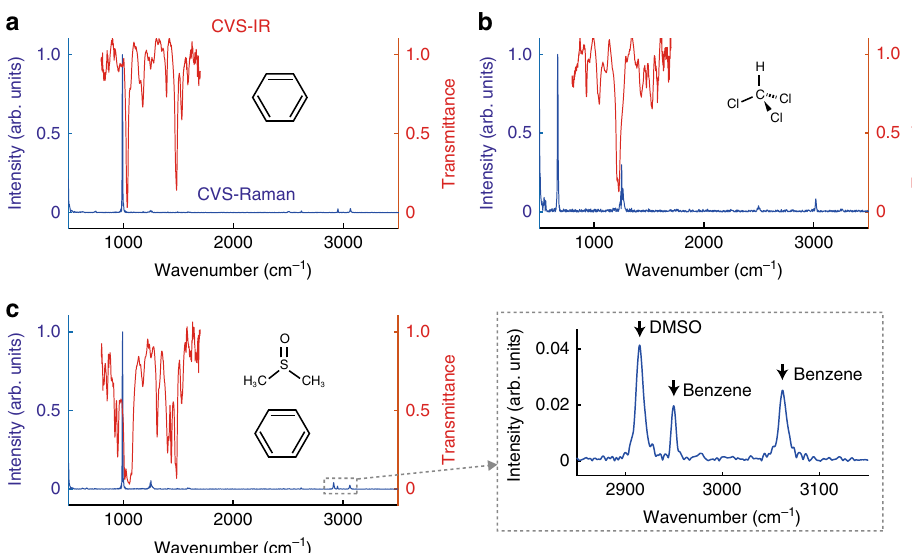
Fig. 4 Complementary vibrational spectra of organic molecules. a benzene, b chloroform, c 4:1 mixture of benzene and DMSO. Red and blue curves represent CVS-IR and CVS-Raman spectra, respectively. The inset shows the zoomed spectrum of the Raman peaks of DMSO and benzene around 3000 cm − 1 . The vibrational lines are found from 800 to 1700 cm − 1 in the CVS-IR spectrum and from 600 to 3100 cm − 1 in the CVS-Raman spectrum. The small spikes at 500 – 550, 750, 1250, and 2500 cm − 1 in the CVS-Raman spectra are attributed to instrumental noise, which can be removed by